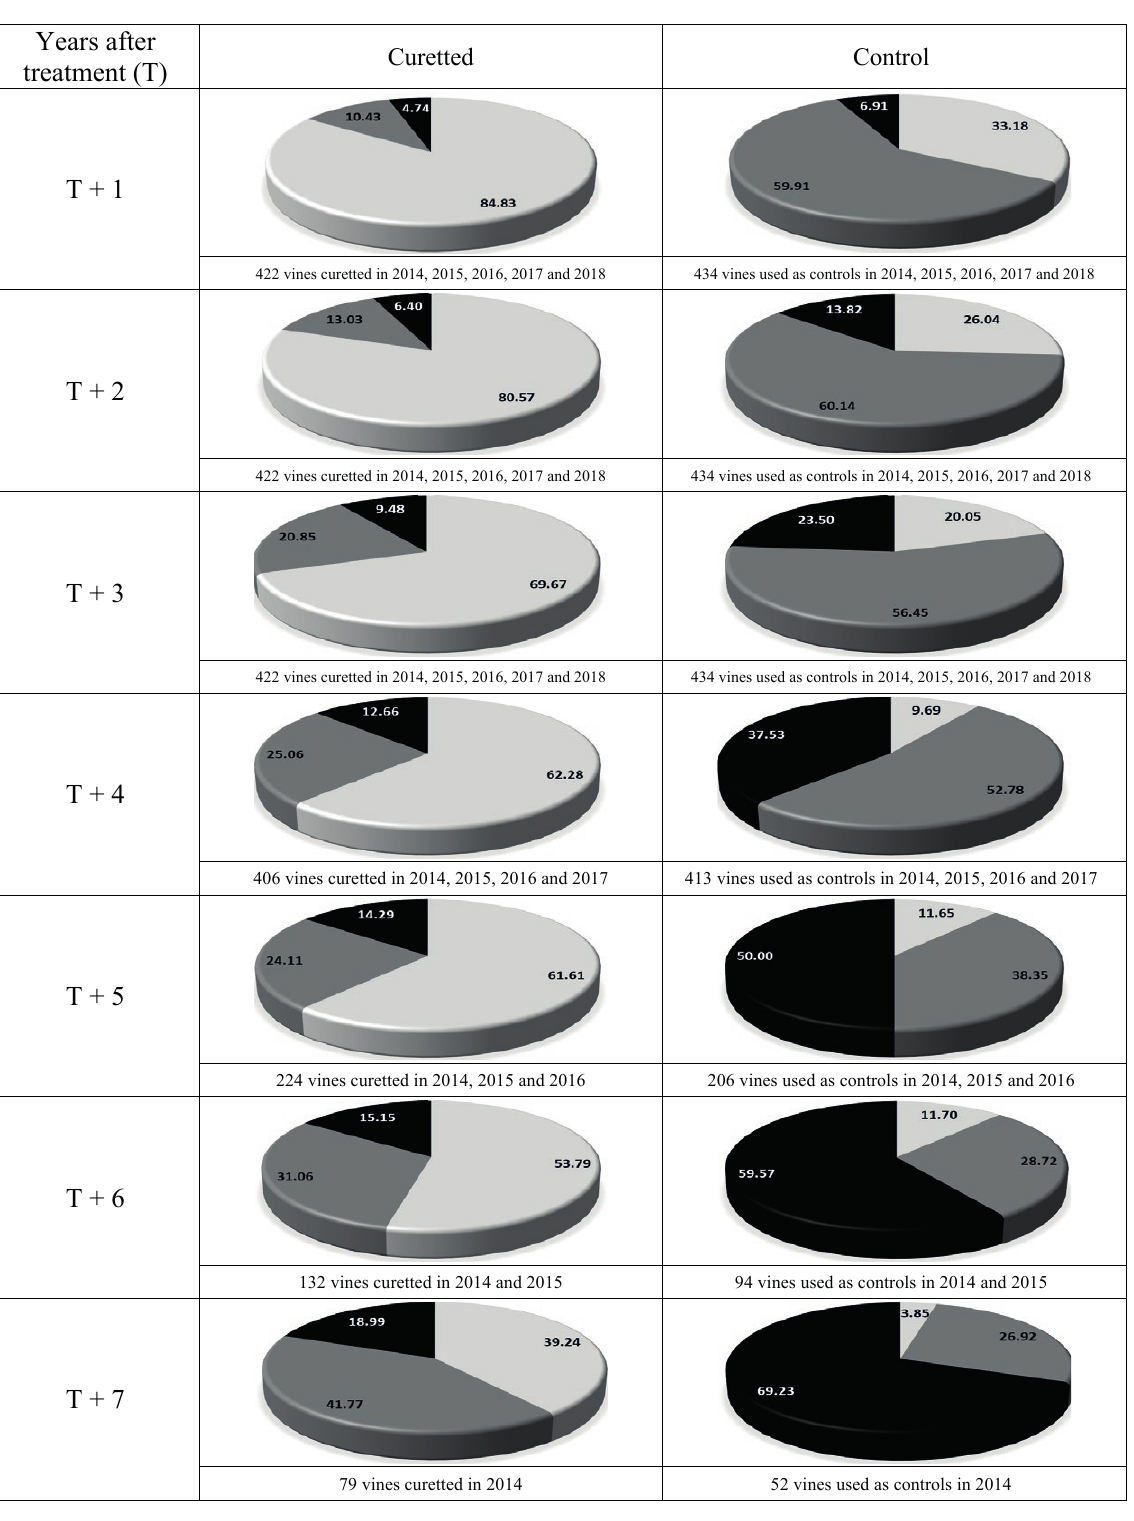
Figure 5. Health status, with respect to esca, for all vines that were curetted or used as experimental controls since 2014 (all experiments combined), 1 to 7 years aft er curettage treatment (T). Percentages of asymptomatic vines are shown in light gray, those of symptomatic vines are in dark gray, and those of dead vines are shown in